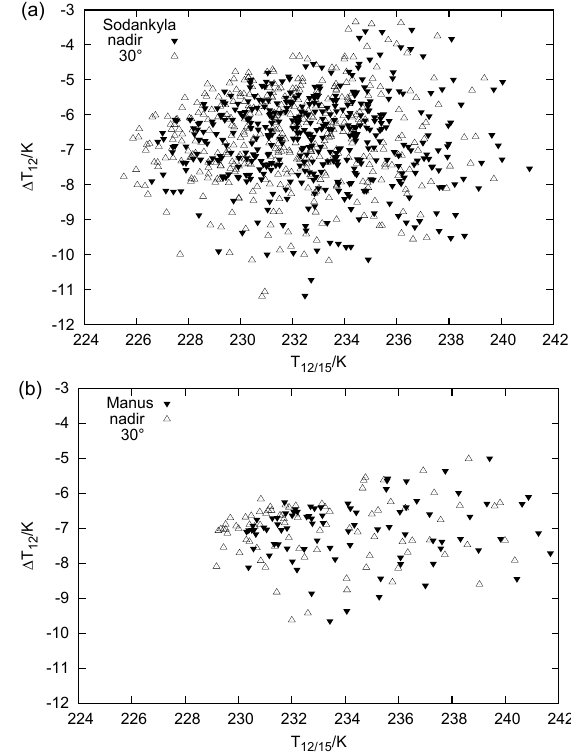
Figure 2. Scatter plot of brightness temperatures calculated with a radiative transfer model using radiosonde profiles from Sodankylä, Finland (a) and Manus, Papua New Guinea (b) . The abscissa repre- sents the brightness temperature obtained with a channel 12 spectral response function for HIRS/3 on NOAA 15. The ordinate repre- sents the difference between this brightness temperature and a cor- responding one computed using the channel 12 spectral response function for HIRS/2 on NOAA 14. The calculations have been per- formed for both nadir and 30 ◦ off-nadir viewing